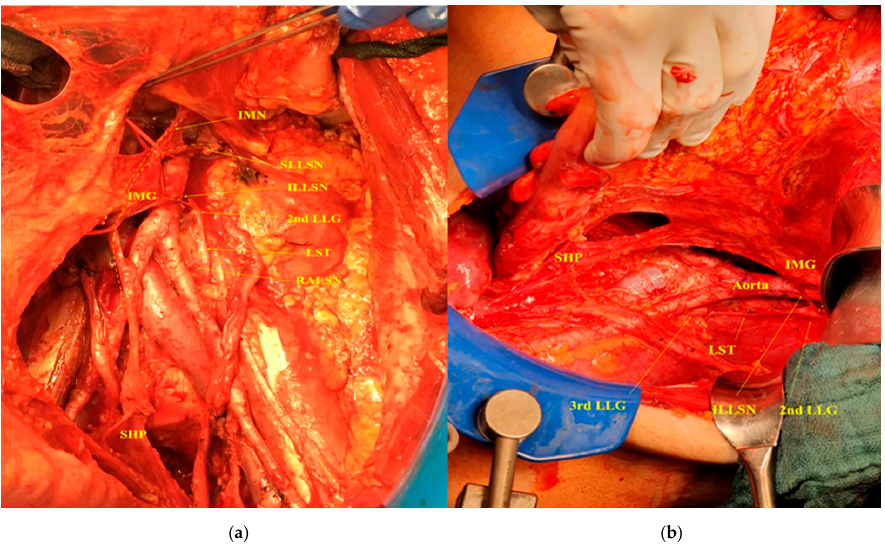
Figure 4. ( a ) Ventral view and ( b ) lateral view of the dissected left cord of the aortic plexus in a patient during the primary cytoreductive surgery for ovarian cancer. IMN, intermesenteric nerve; SLLSN, superior left lumbar splanchnic nerve; ILLSN, inferior left lumbar splanchnic nerve; 2nd LLG, left lumbar ganglion; LST, left sympathetic trunk; RALSN, retroaortic lumbar splanchnic nerve; IMG, inferior mesenteric ganglion; SHP, superior hypogastric